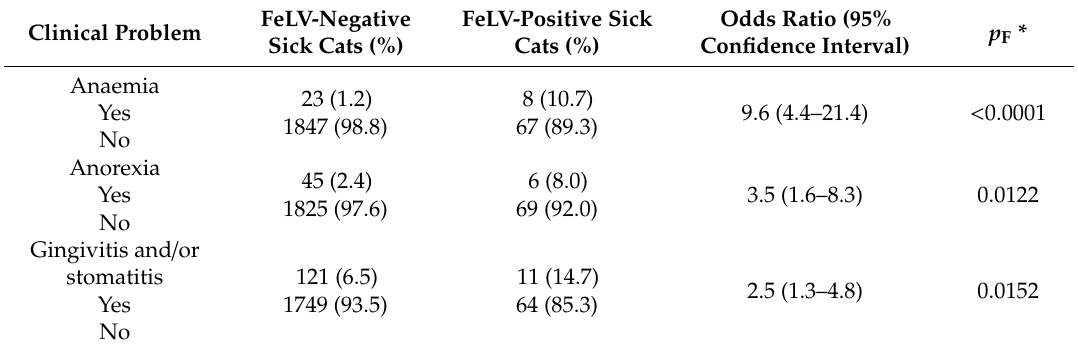
Table 5. Major clinical problems reported in FeLV viraemic sick cats in comparison with all sick